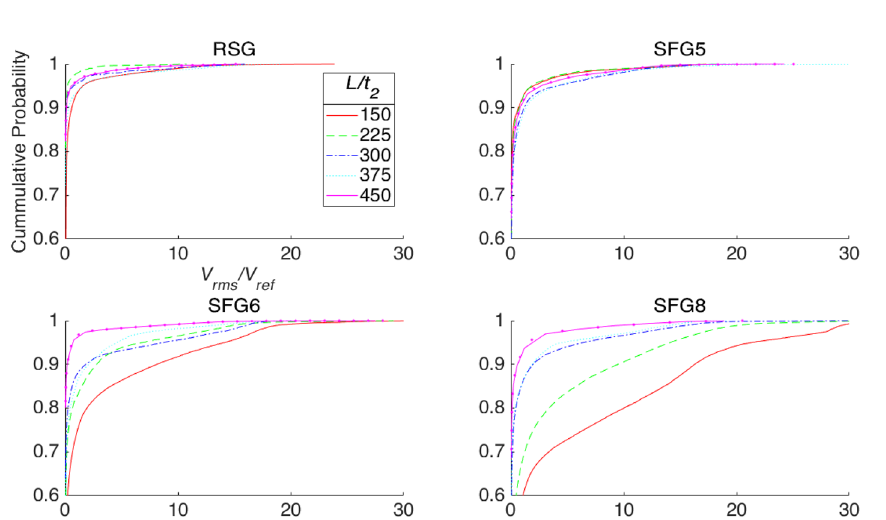
Figure 7. Cummulative probability of each 2D planar space-filling insert’s normalized V rms . (note: prepared in Matlab R2018A, https:// www. mathw orks. com/ produ cts/ matlab.